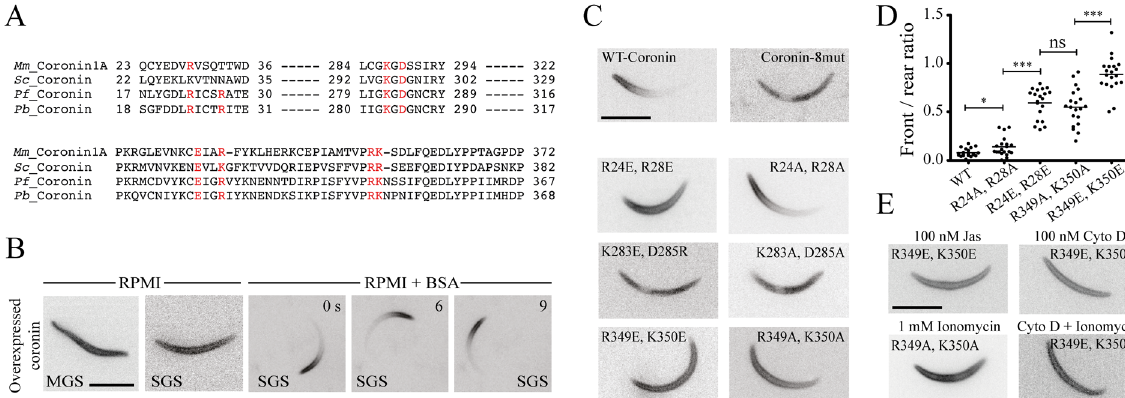
Fig 2. Mutant coronins reveal distinct binding to membranes and actin filaments. (A) Multiple sequence alignment shows that amino acids found to be important for actin binding in yeast are conserved between mouse, yeast and apicomplexans and are marked in red. (B) Fluorescence microscopy of a parasite line overexpressing coronin-mCherry from the uis3 promoter. Note the peripheral fluorescence in non-motile (RPMI) and motile (RPMI+BSA) salivary gland derived sporozoites. Numbers indicate time in seconds. Scale bar: 5 μ m. (C) Localization of a number of overexpressed mutant coronin-mCherry fusion proteins. Note the three different types of localizations: cytoplasmic (coronin-8mut; K283A/E, D285A/R), peripheral (R24E, R28E; R349A/E, K350A/E) and polarized (WT, R24A, R28A). Scale bar: 5 μ m. (D) Graph showing a quantitative assessment of the front versus rear ratio from 20 images of the various parasite lines overexpressing mutated coronin-mCherry as indicated on the x-axis. (E) The peripheral localization of R349A/E, K350A/E mutants is not altered when sporozoites are incubated with cytochalasin (100 nM), jasplakinolide (100 nM), ionomycin (1000 nM) or cytochalasin D (100 nM) + ionomycin (500 nM) Scale bar: 5 μ m.